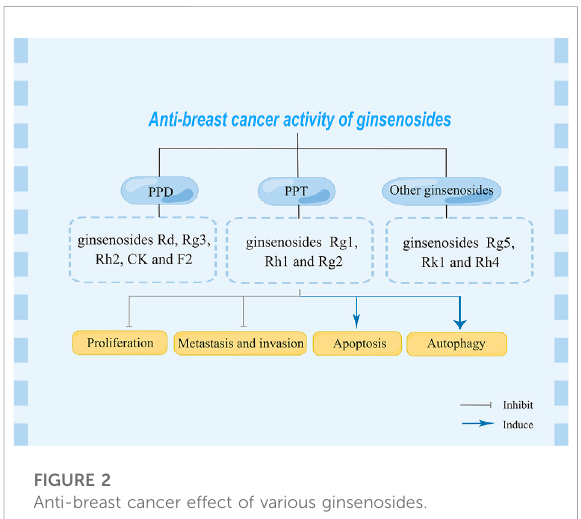
FIGURE 2 Anti-breast cancer effect of various